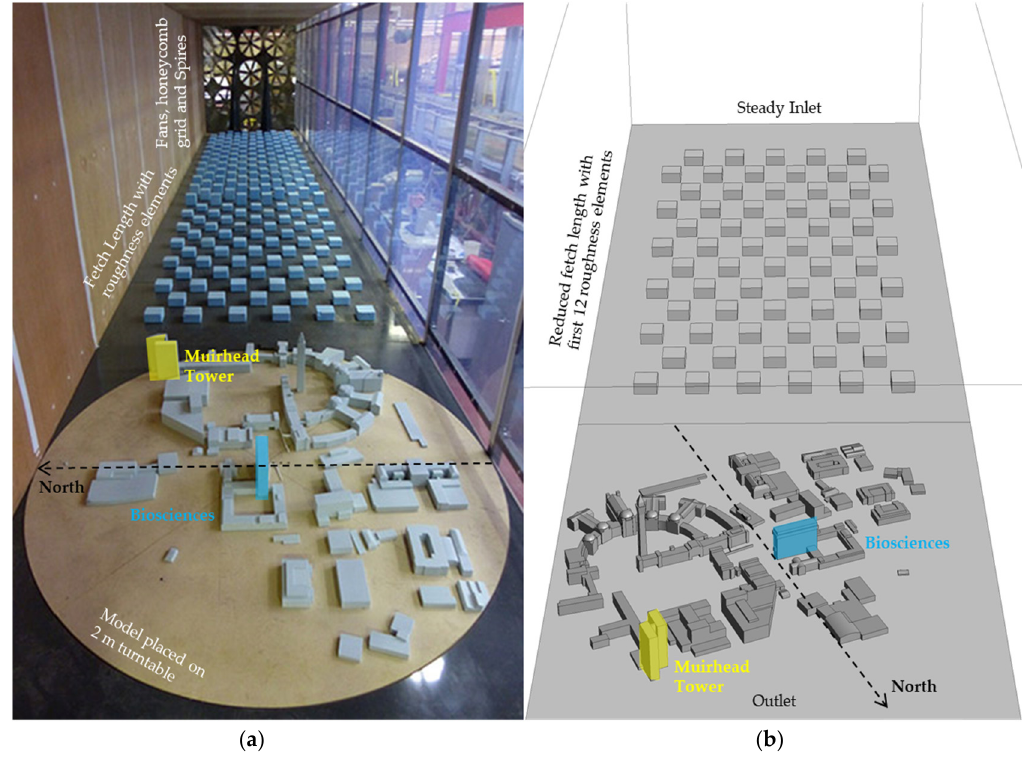
Figure 1. ( a ) Wind tunnel setup and ( b ) numerical setup.